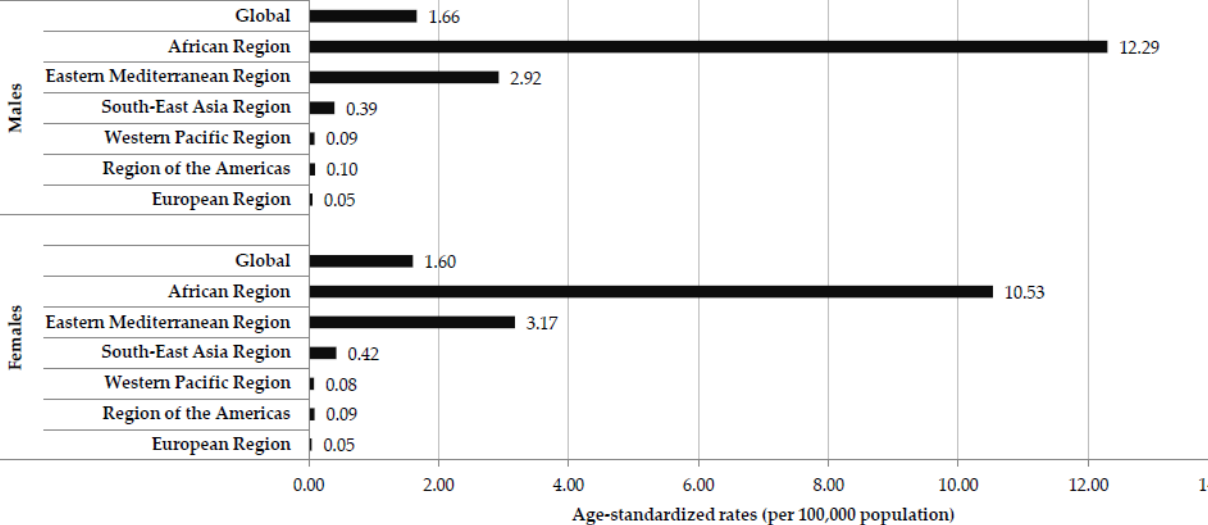
Figure 3. Mortality of cholera (global and by regions of World Health Organization), by sex, 2019 (Source of data Ref. [10]).